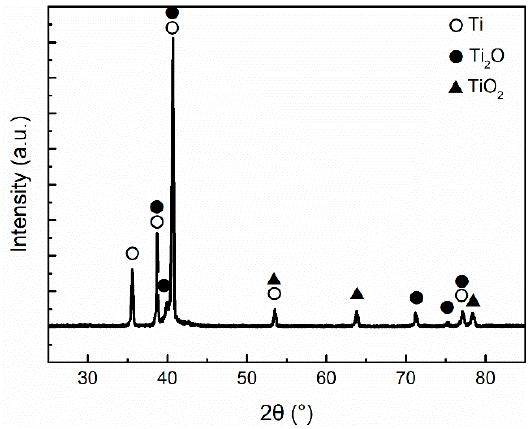
Figure 7. XRD diffractogram of Ti-6Al-4V titanium alloy after salt spray corrosion for 576 h.